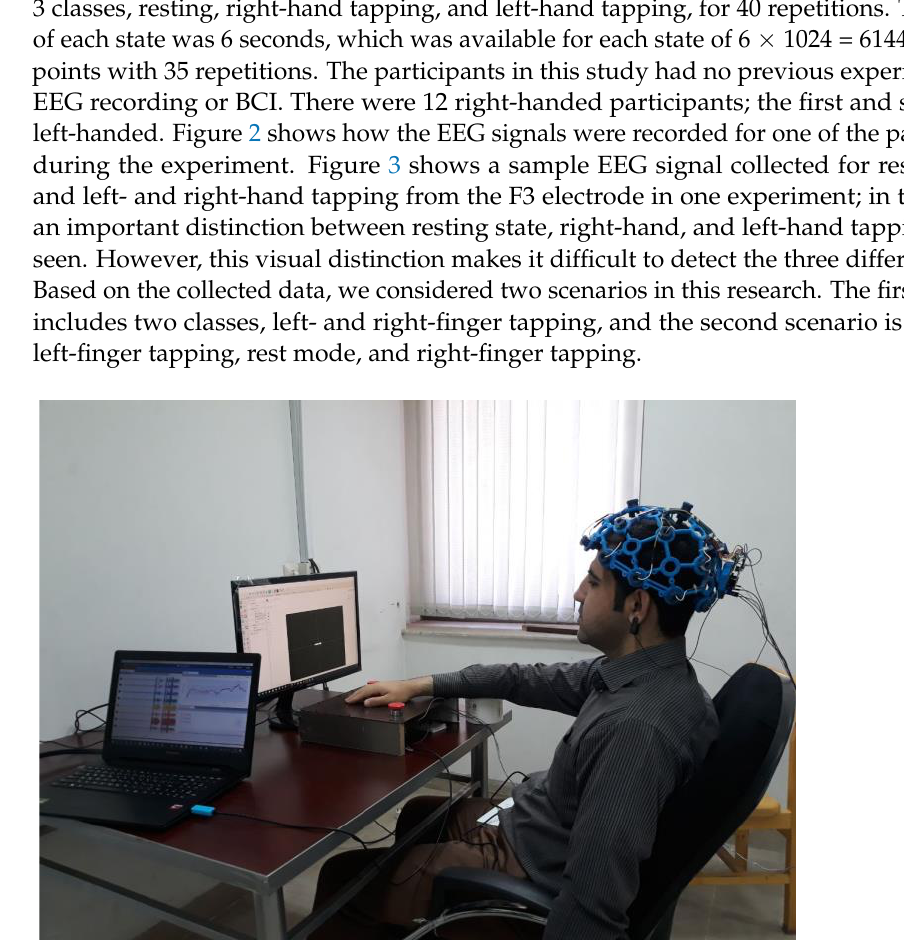
Figure 3. Part of the EEG signal for resting, left-hand, and right-hand stages of F3 channel for subject 1. 3.2. Preprocessing According to the data dimensions for each class (resting state, left-hand tapping, right-hand tapping) equal to 6 seconds (6144 sampling points) with 35 repetitions (35 × 6144 = 21,504), for each subject, six pairs of electrodes were considered (F3-C3, Fz-Cz, F4- C4, C3-P3, Cz-Pz, C4-P4); we therefore obtained 2 × 21,504 sampling points of data. In order to avoid overfitting, the data for every electrode were then separated into 4135 sam- pling points utilizing the overlap approach, and we had 1020 samples for each class. Since the two electrodes were used, each class ’ s sample size and initial characteristics were (2 × 4135) × 1020. In addition, for the two-class scenario, involving Class 1 (right-hand move- ment) and Class 3 (left-hand movement), together considered Class 1, the dimensions were (2 × 4135) × 2040. As with the three-class scenario, the dimensions of each class were (2 × 4135) × 1020. The signals were also normalized using a min – max normalizer between zero and one; subsequently, the data were subjected to a Notch filter to eliminate the power supply ’ s 50 Hz frequency. We also focused only on F3-C3, Fz-Cz, F4-C4, C3-P3, Cz- Pz, and C4-P4 channels for simulation according to [27] to avoid high computational effi- ciency. Figure 4 shows this operation.